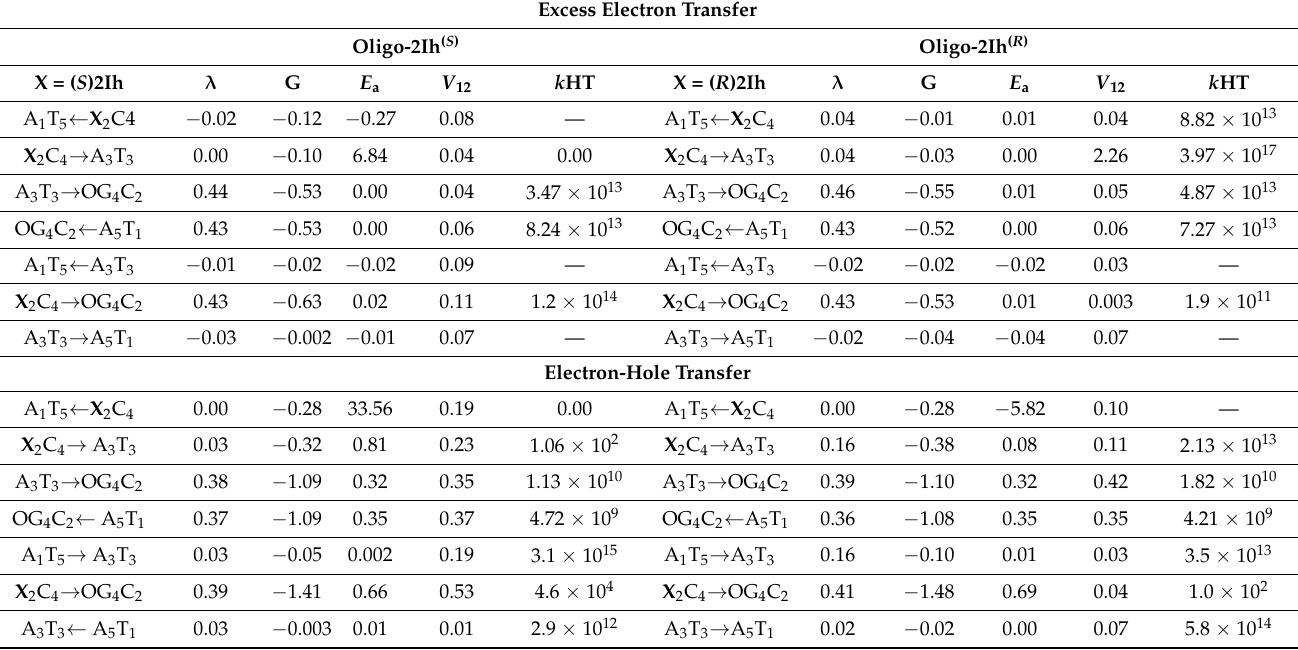
Table 3. The ∆ G, λ , E a , V 12 , and k HT of permissible electron-hole and excess electron transfer between base pairs of oligo-2Ih ( S ) and oligo-2Ih ( R ) , calculated at the m062x/6-31++G** level of theory in the aqueous phase. Arrows indicate the direction of charge